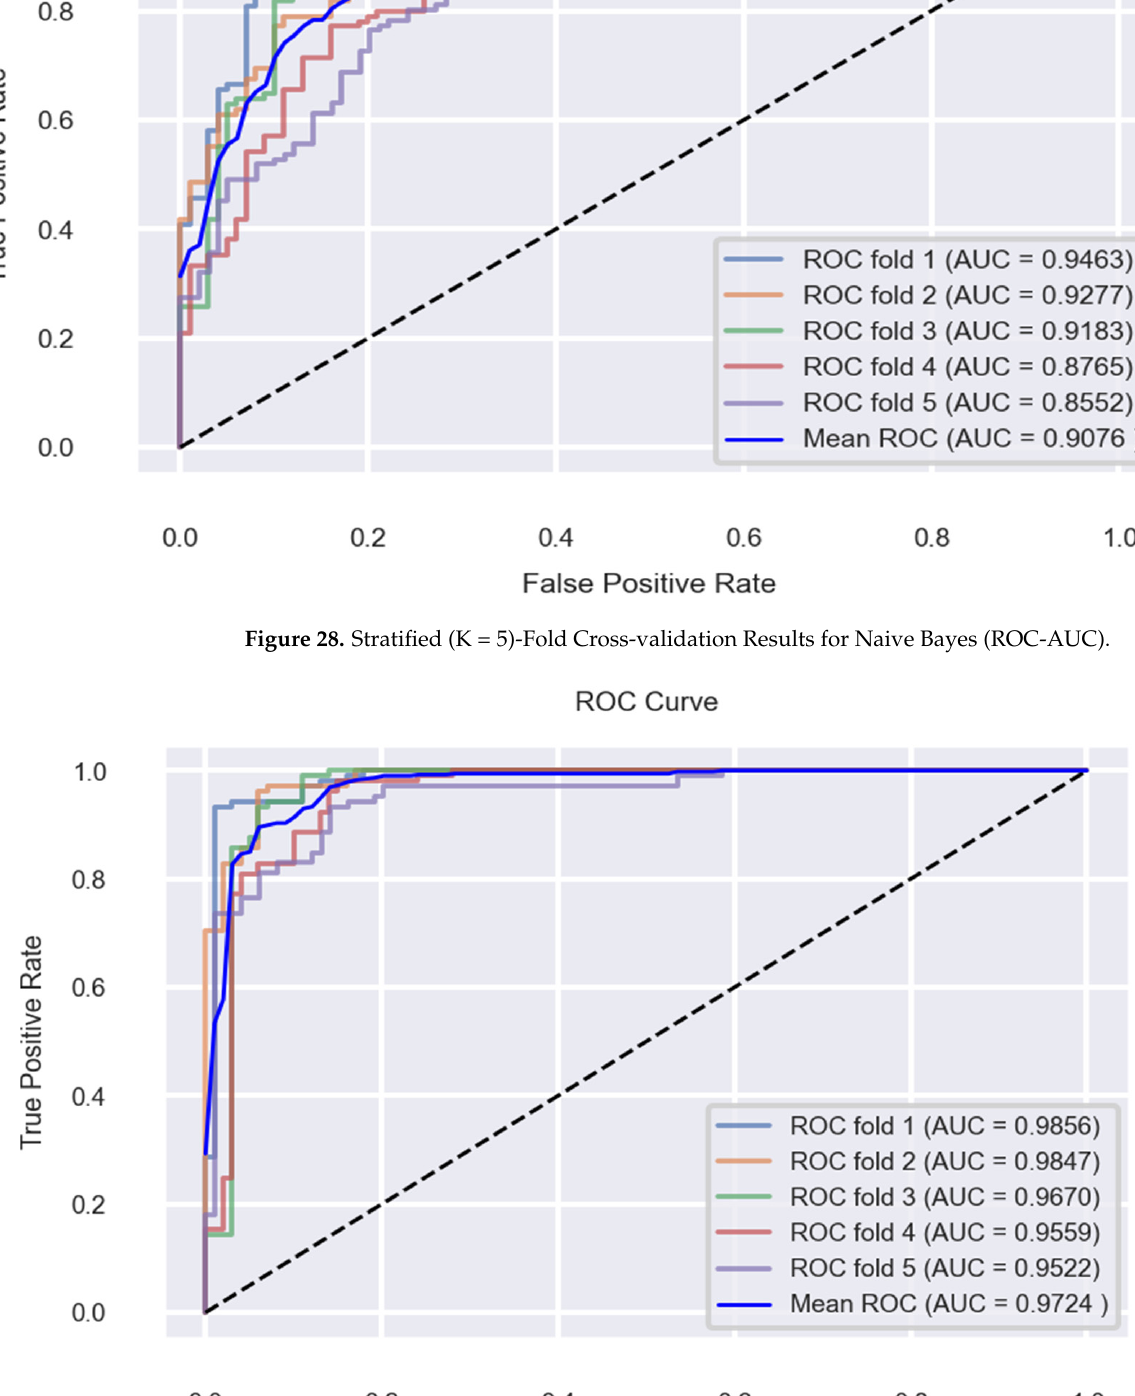
Figure 29. Stratified (K = 5)-Fold Cross-validation Results for Support Vector Machine (ROC-AUC).